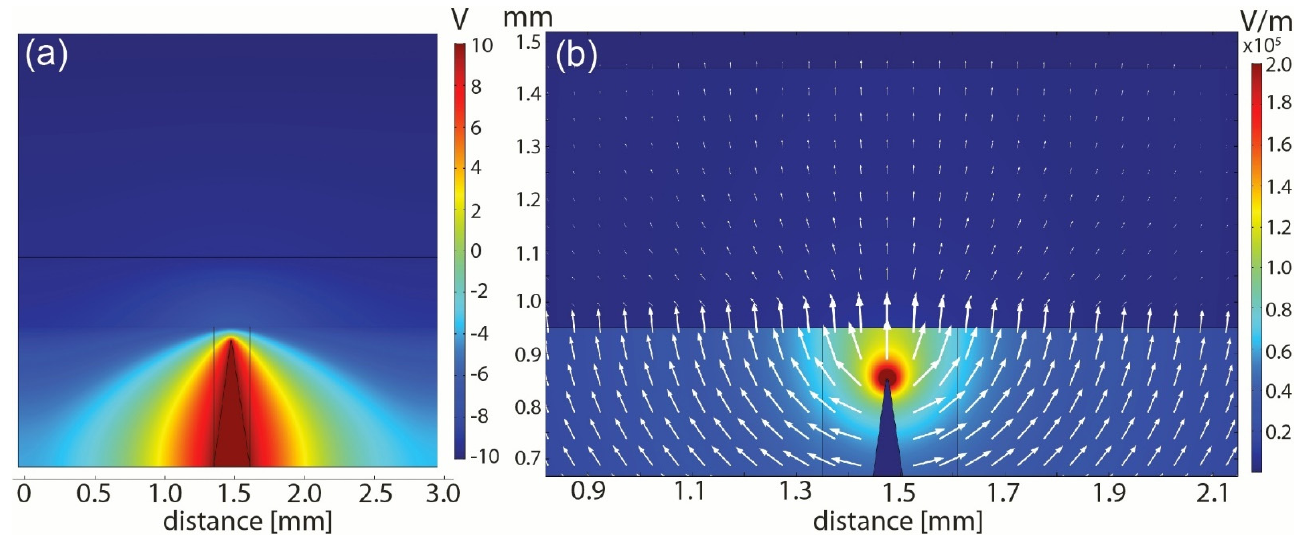
Figure 6. FEM analysis of the dielectrophoretic deposition system in the very center of the microflu- idic chip. ( a ) The potential (U) between the DEP electrode (needle) and the counter − electrode (very top of the figure). ( b ) The electric field (EF) distribution between the two electrodes.